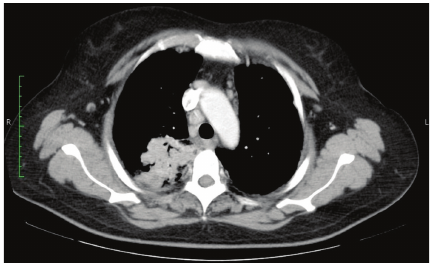
Figure 4: Computed tomography (CT) scan showing an irregular mass in the right lung field. This lesion was initially diagnosed as a cryptogenic organizing